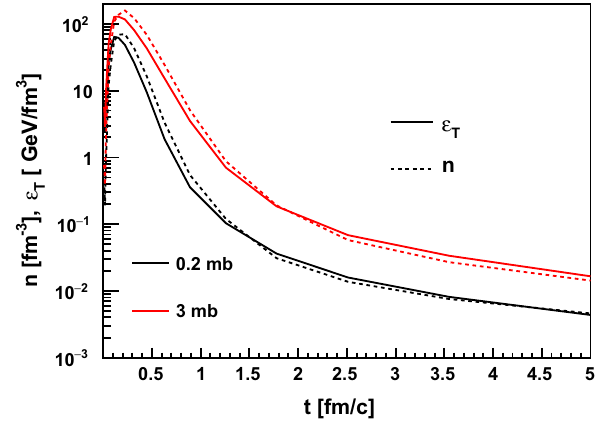
Fig. 6 Charged hadron pseudo-rapidity distribution in pp 13 TeV with no final state rescattering (solid line), only parton rescattering with 3mb cross section (dashed line), only hadron rescattering (dotted line) and combined parton/hadron rescatterings (long dashed line) compared to ALICE data in inelastic (black circle) and INEL > 0 events (red circle) [74]. Black lines and red lines are the model calculations obtained with the ALICE INEL and INEL > 0 cut, respectively